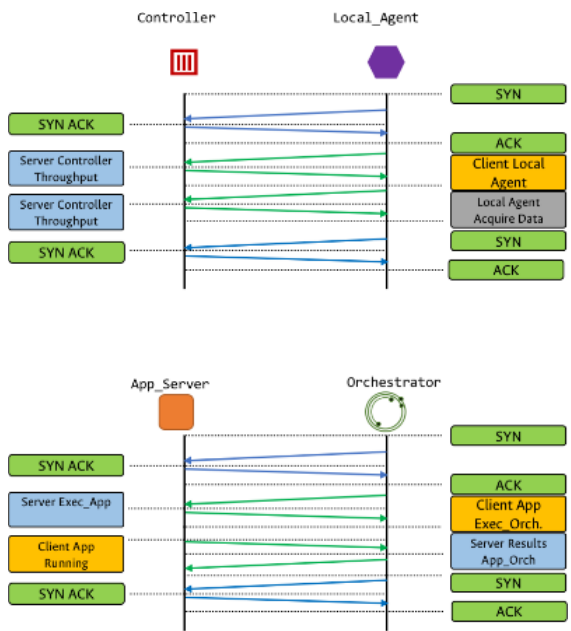
Figure 5. Local Agent Applications Communication.